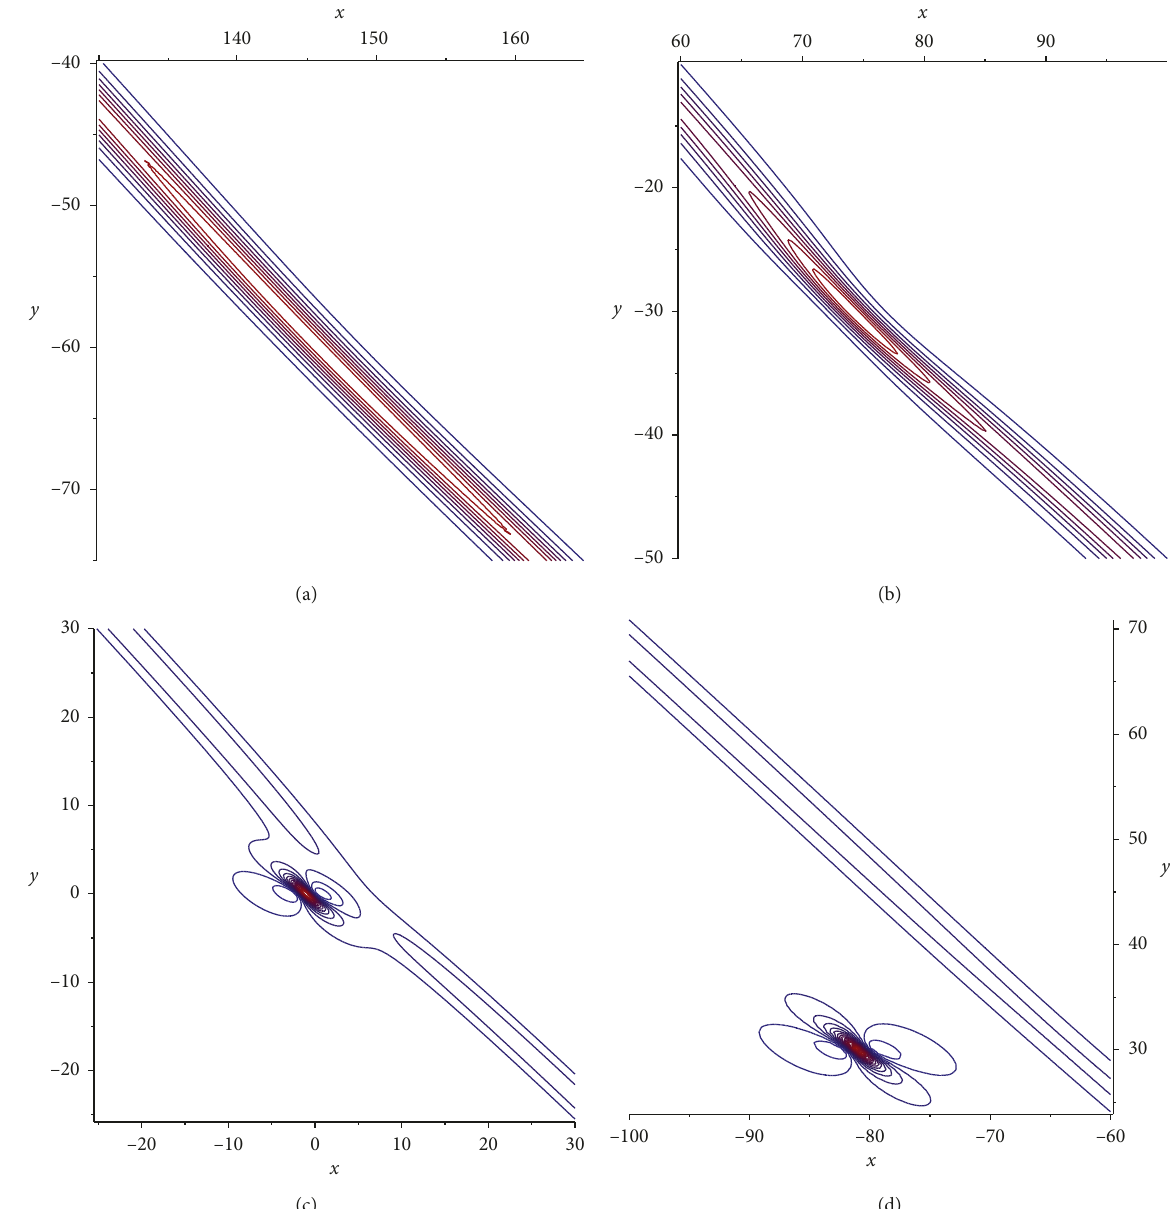
Figure 4: The contour plot of solution (25) with z � 0 and different time t : (a) t � − 40; (b) t � − 20; (c) t � 0; (d) t �